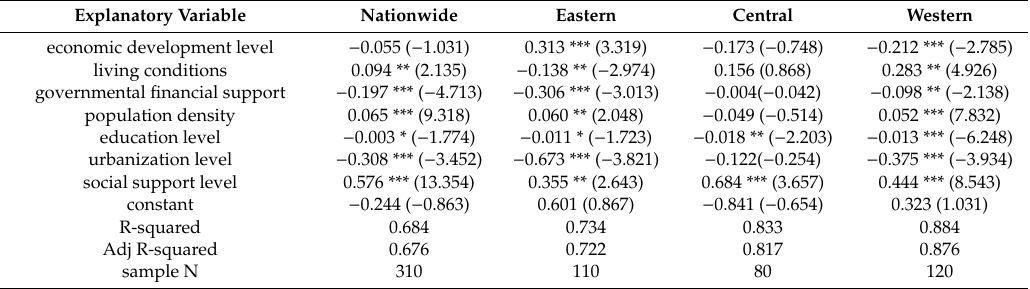
Table 4. Bootstrap truncated regression results of influencing factors of allocation e ffi ciency of rural public health